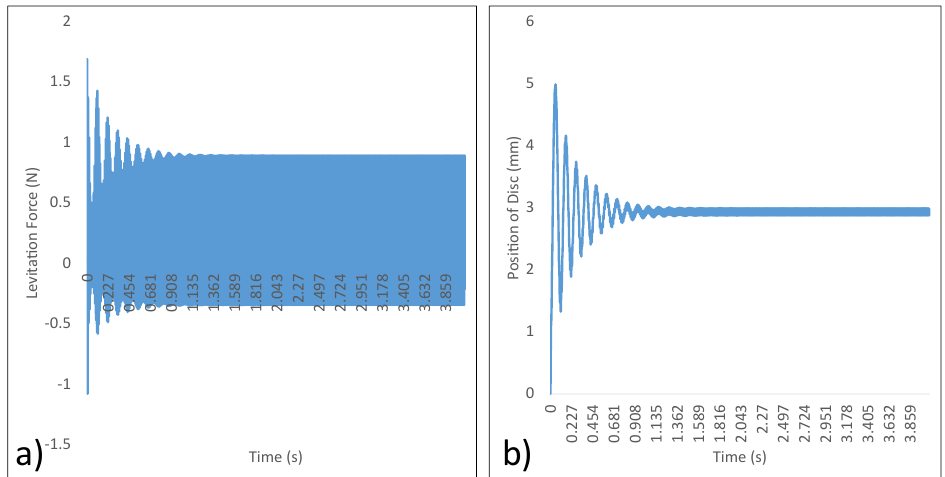
Figure 17. Stability of the disc in the axial axis ( a ) Levitation force vs. time ( b ) Position of disc vs. time.